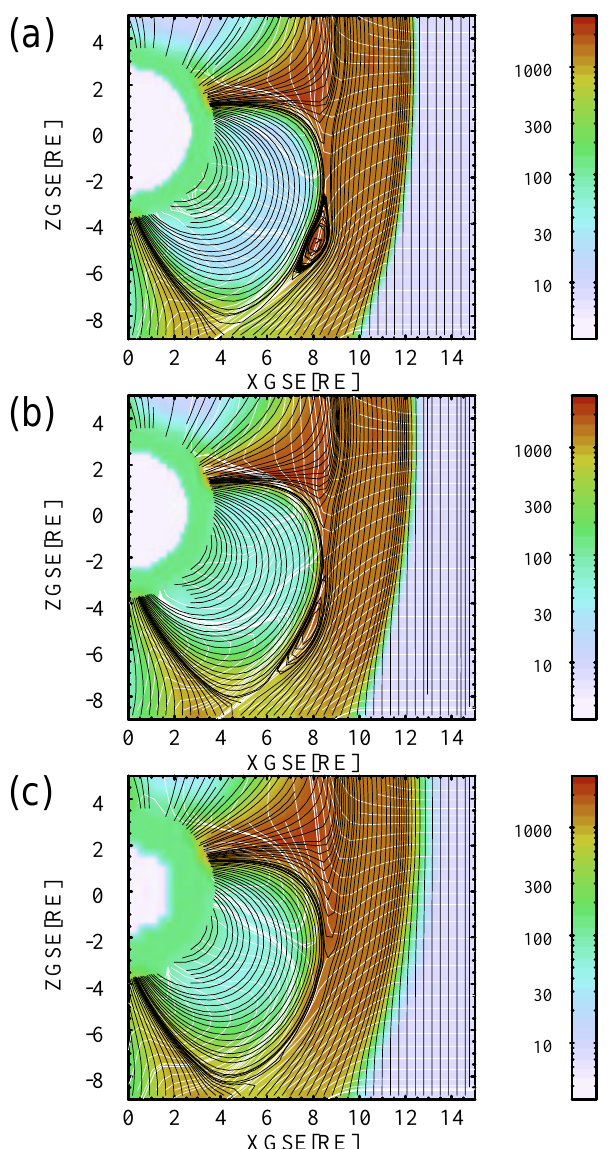
Fig. 2. Three simulations with identical parameters except for the grid resolution: (a) highest resolution (0.08 R E , ∼ 500km), (b) medium resolution (0.15 R E , ∼ 1000km), and (c) low resolution (0.3 R E , ∼ 2000km). FTEs only develop fully with the highest res- olution. At medium resolution they are smaller and rapidly dif- fuse away, and at the lowest resolution no FTEs appear but “flow through” reconnection develops instead. The color represents the plasma